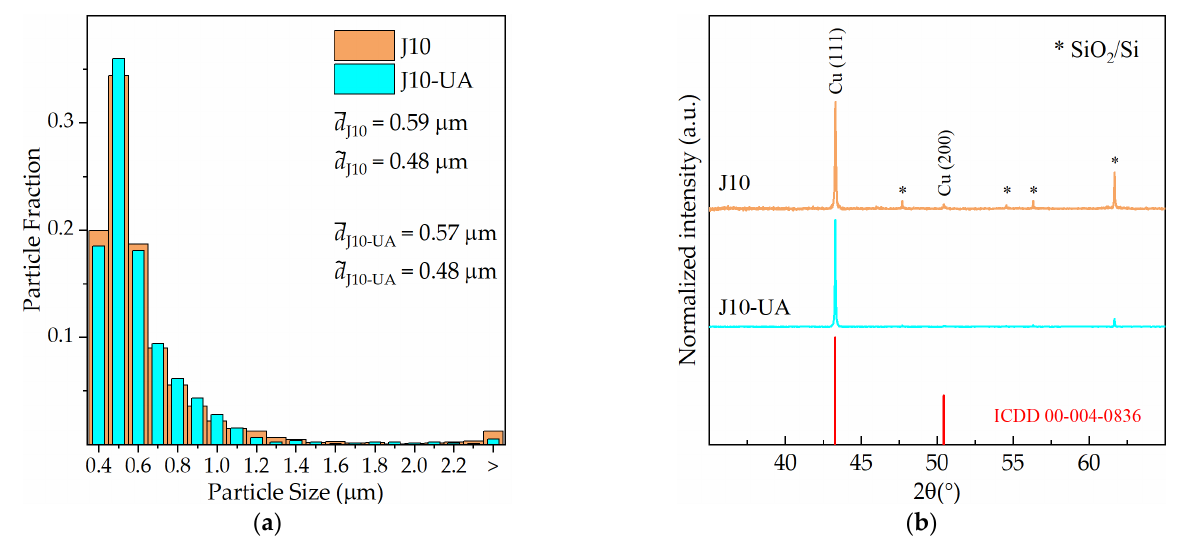
Figure 11. Particle size distributions for current density of 10 mA·cm −2 with (J10-UA) and without (J10) agitation ( a ), and their respective X-ray diffractograms ( b ).